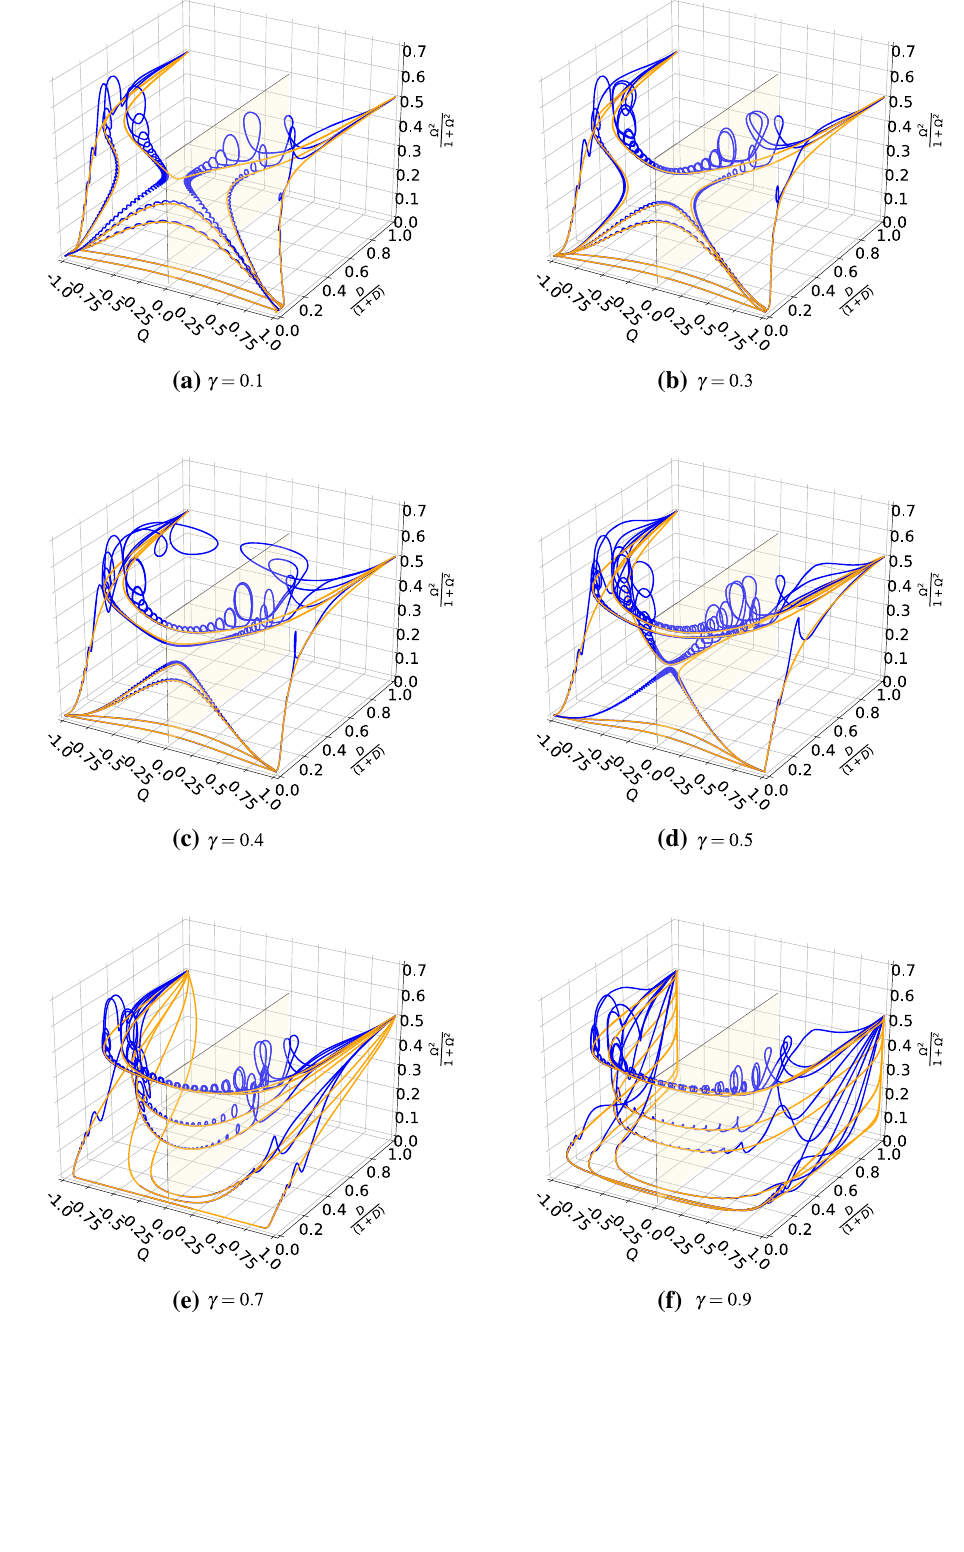
Fig. 25 Some solutions of the full system (118) (blue) and time-averaged system (145) (orange) for the closed FLRW metric when γ = 0 . 1, 0 . 3, 0 . 4, 0 . 5, 0 . 7, and 0 . 9, respectively; all of them represented in the space ( Q , D /( 1 + D ),(cid:8) 2 /( 1 + (cid:8) 2 )) . We have used for both systems the initial data sets presented